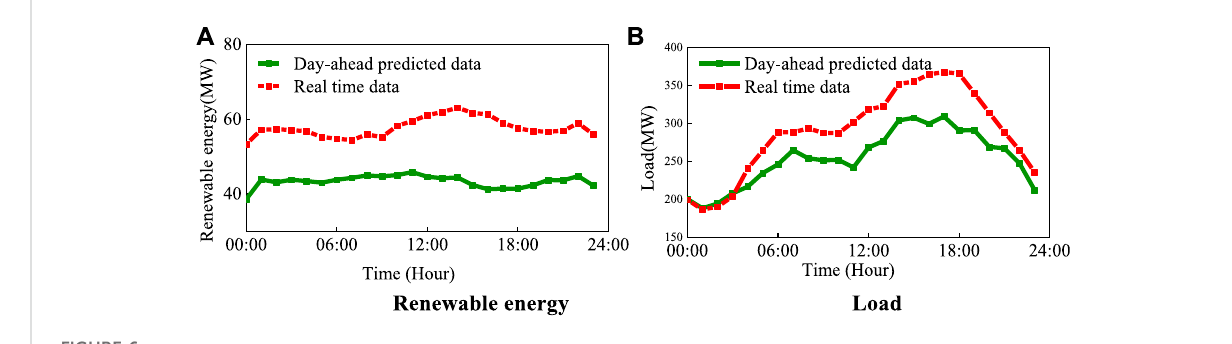
FIGURE 6 Transaction process of the slot-ahead ancillary market for peak-regulation. (A) Renewable energy and (B) load.